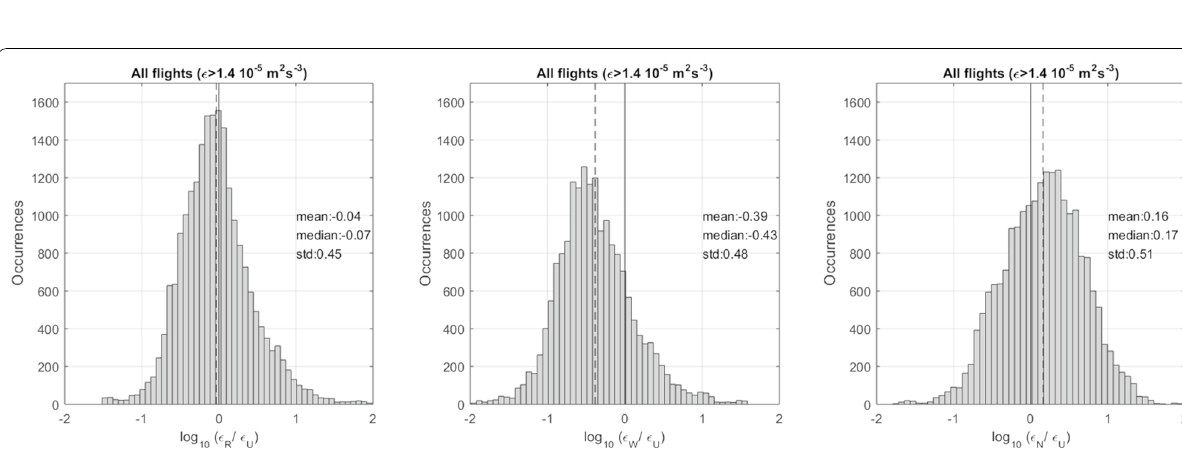
for weak values). The slopes of the regression line shows the results of regression and correlation analy- are close to 1, 0.91 and 0.92, between log 10 ( ε U ) and ses between ε U and the three radar estimates assuming ( ε R ) and between log ( ε U ) and log ( ε W ) , respec- log errors on both variables, and after rejecting dissipation 10 10 10 × 10 − 5 m 2 s − 3 3 rates smaller than 1.6 (because of the tively, confirming reasonably, the σ dependence of radar detection threshold and residual contaminations TKE dissipation rates. The corresponding correlation